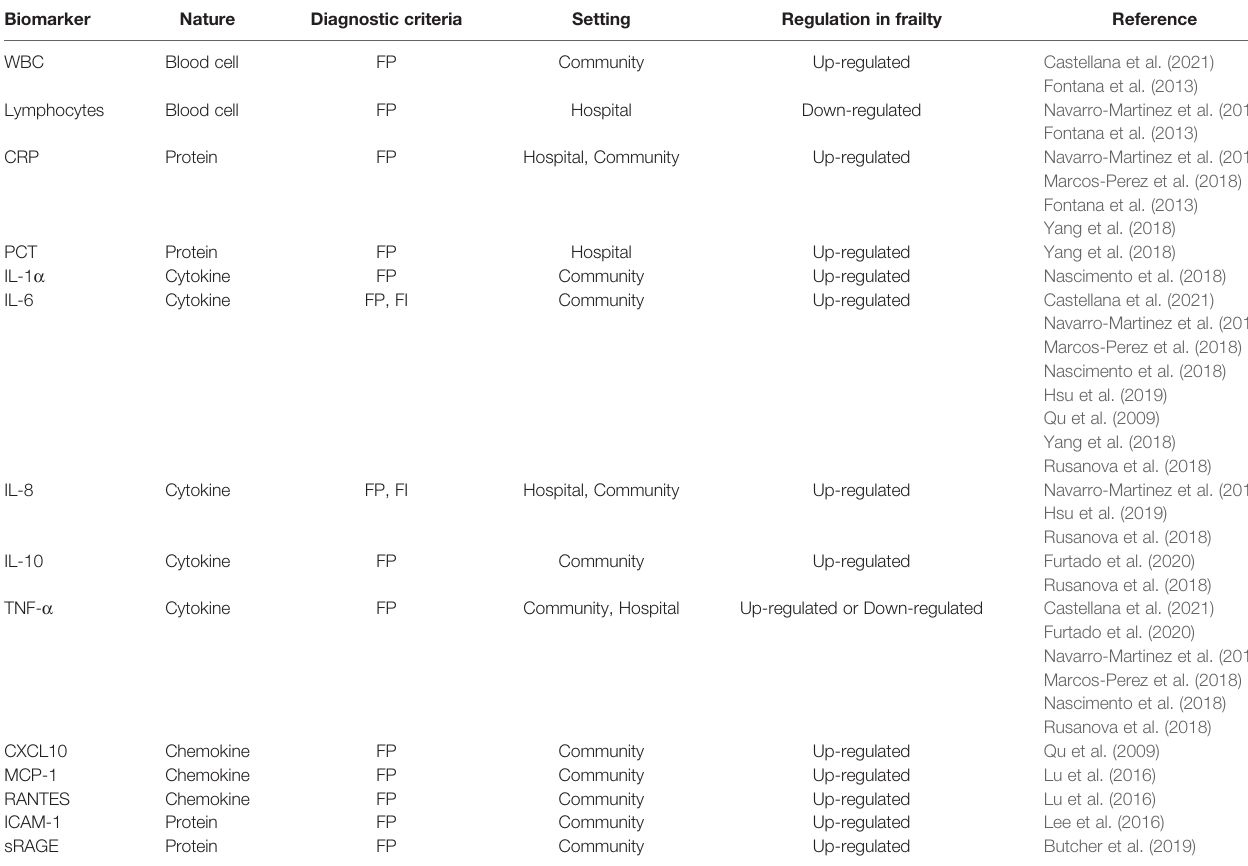
TABLE 1 | Potential in fl ammatory biomarkers of older adults with frailty.